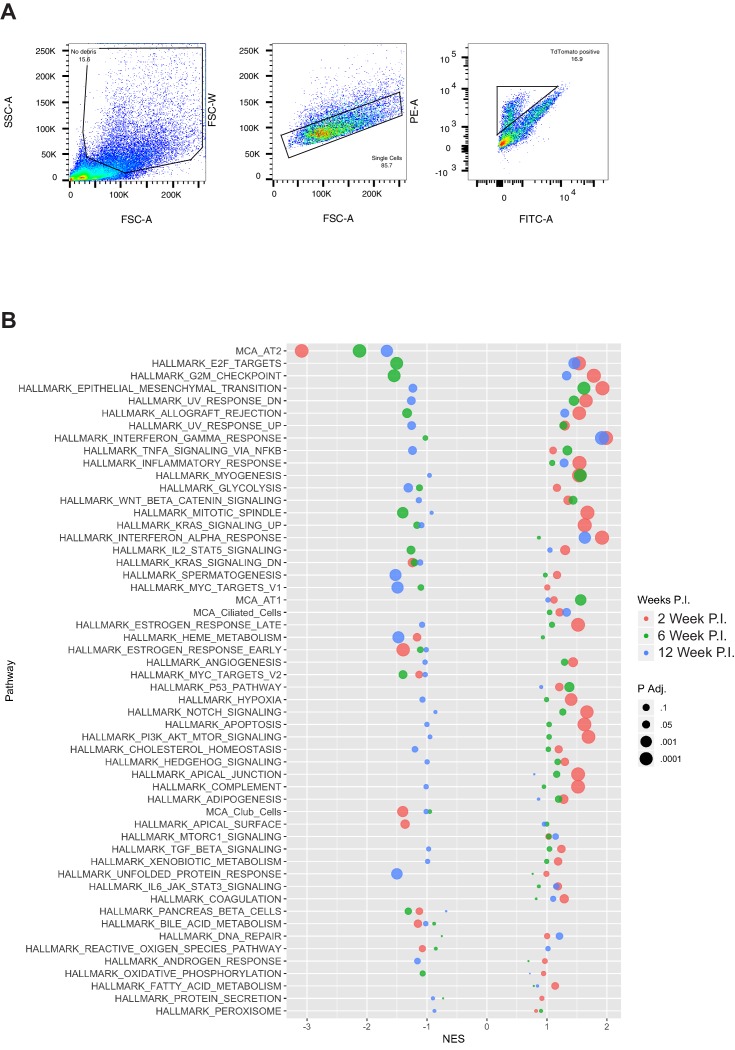
Examining global gene expression changes caused by combination of PI3K and MAPK activation using RNA-SEQ.(A) Expanded view of GSEA analyses comparing results at each individual time point. Point size inversely proportional to adjusted enrichment statistic p value, color indicates time point at which comparison was performed. (B) In depth gating strategy used for isolation of all FACS sorted tumor cells in this study.